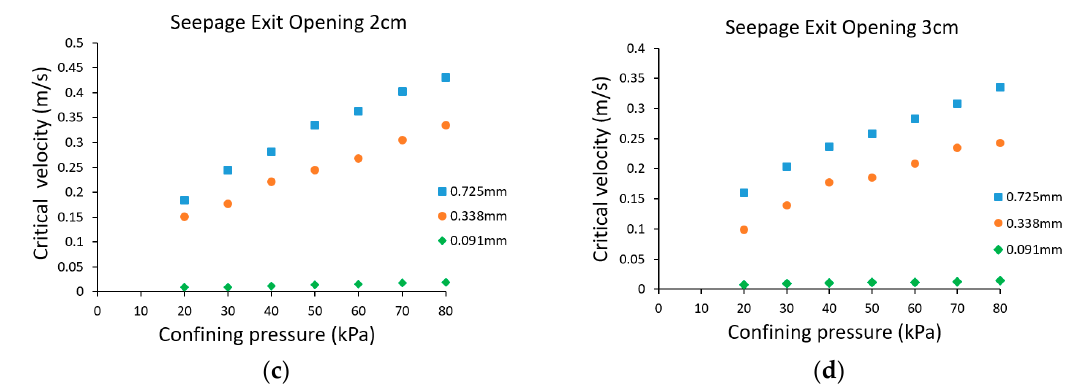
Figure 5. Critical velocity with various confining pressure: ( a ) seepage exit opening of 0.4 cm; ( b ) seepage exit opening of 1 cm; ( c ) seepage exit opening of 2 cm; ( d ) seepage exit opening of 3 cm.